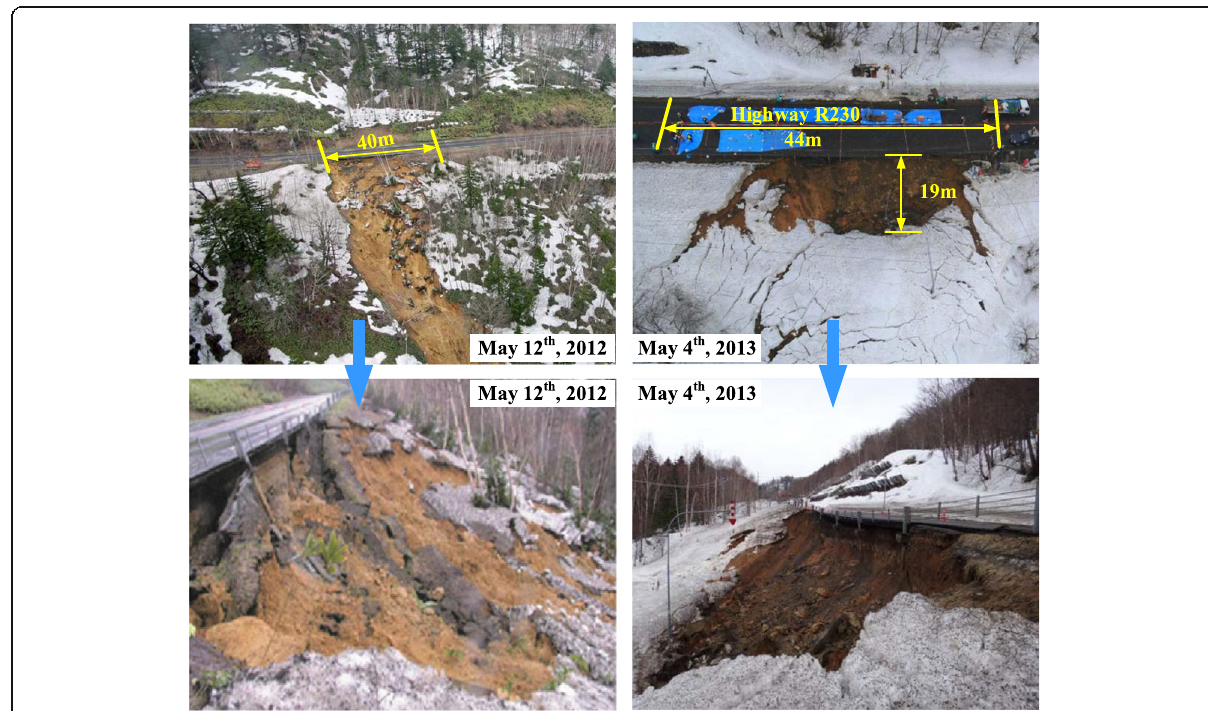
Fig. 11 Slope failures at Nakayama Pass on Route